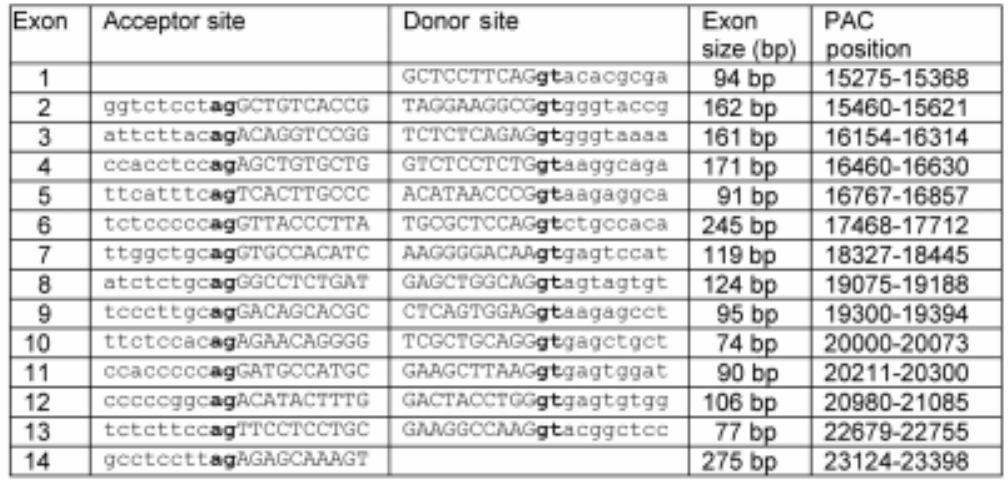
Figure 1. A , cDNA (AF247666) and predicted protein sequence of DDX26. Primers used for amplification and sequenc- ing are marked in bold and the putative polyadenylation site is underlined. The putative initiation methionine was considered to be the first ATG codon in the sequence. B , Intron/exon junctions of DDX26. Upper and lower case letters correspond to the exon and intron sequences, respectively. The conserved bases in the 5’donor and 3’acceptor splice site junctions are shown for each exon in bold. Exon size and position, based on the PAC DJ0971C03 sequence, are